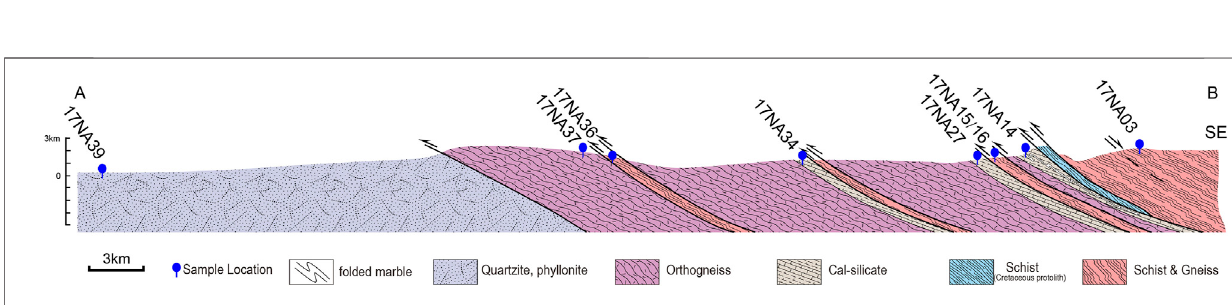
( Figure 4H ). In the southernmost part of the Arun Valley, ( Figure 3H ). Sample 17NA39 was collected from the layered quartzite that was made of fi nely recrystallized quartz ( Figure 4I ).